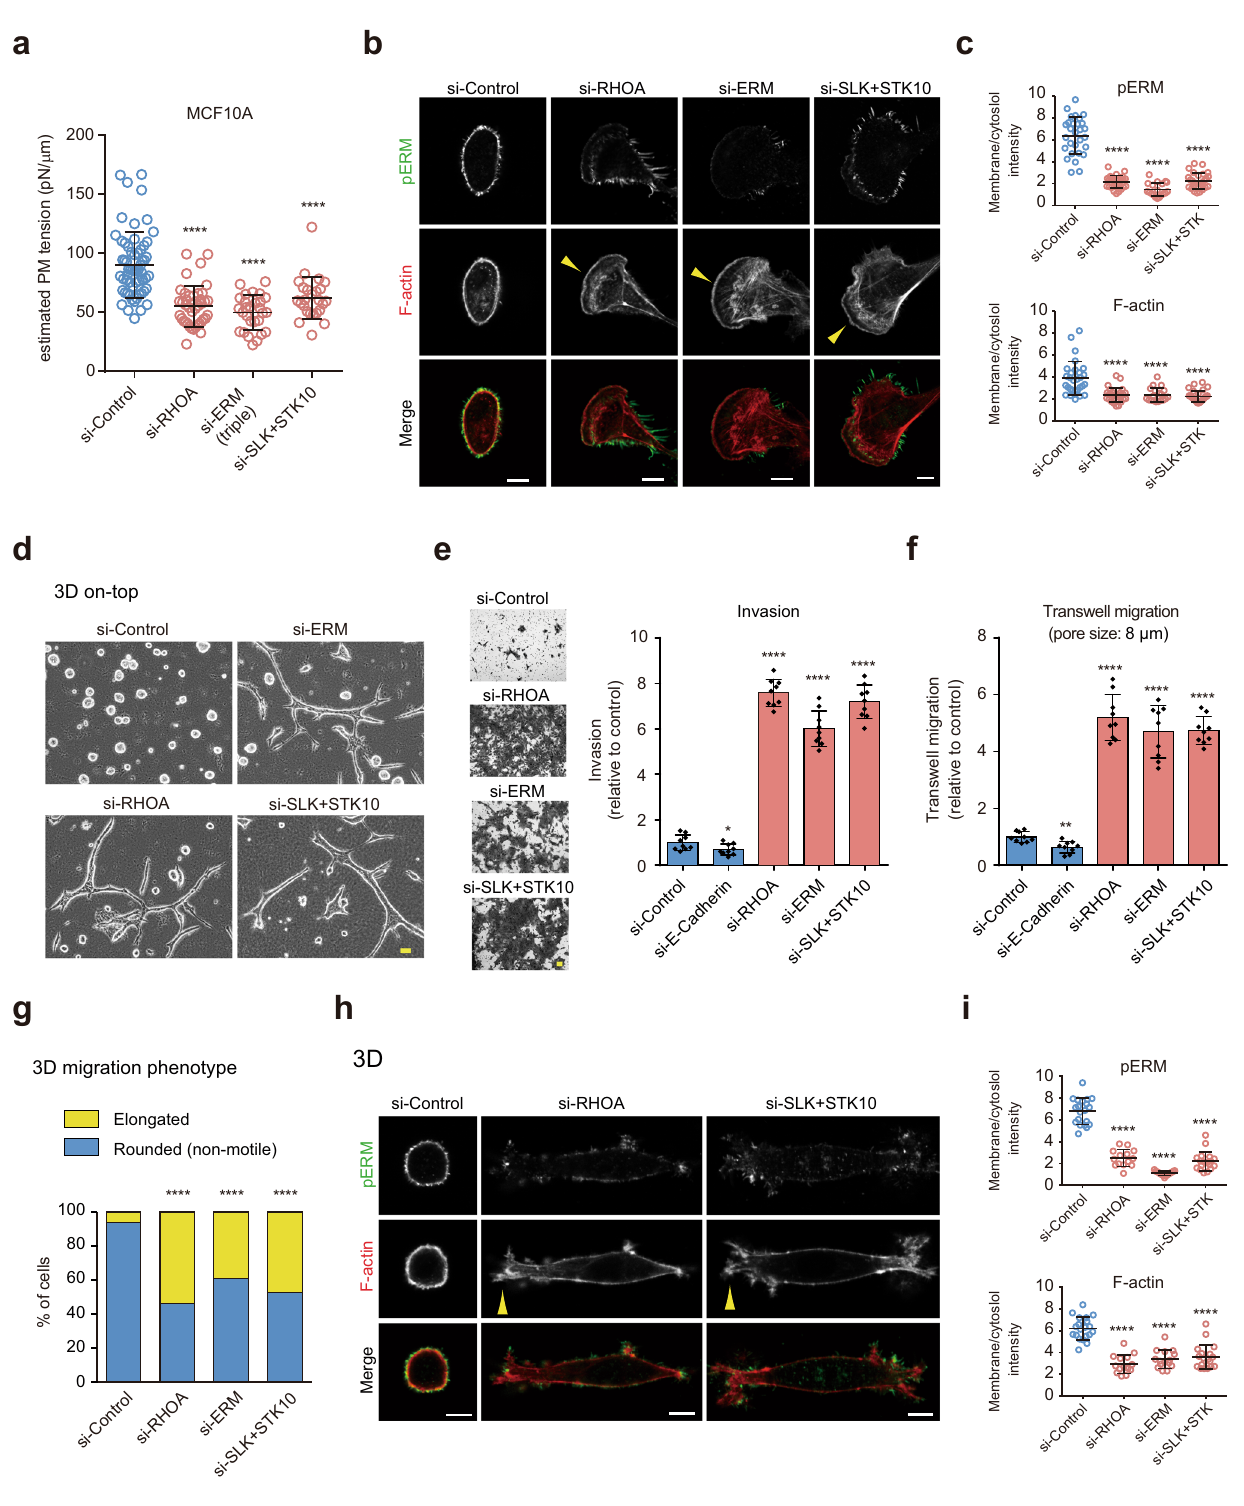
compound that increases PM tension 23,47 (Supplementary Fig. 4c) but decreases cortical stiffness 48 , signi fi cantly reduced invasion (Supplementary Fig. 4b), ruling out potential effects of cortical stiffness on inhibiting cancer cell migration. Next, we tested whether an increase in PM tension affected 3D migration. 3D reconstituted confocal images showed that while ezrin-expressing cells displayed different protrusion phenotypes, as in parental cells, MA-ezrin-expressing cells had